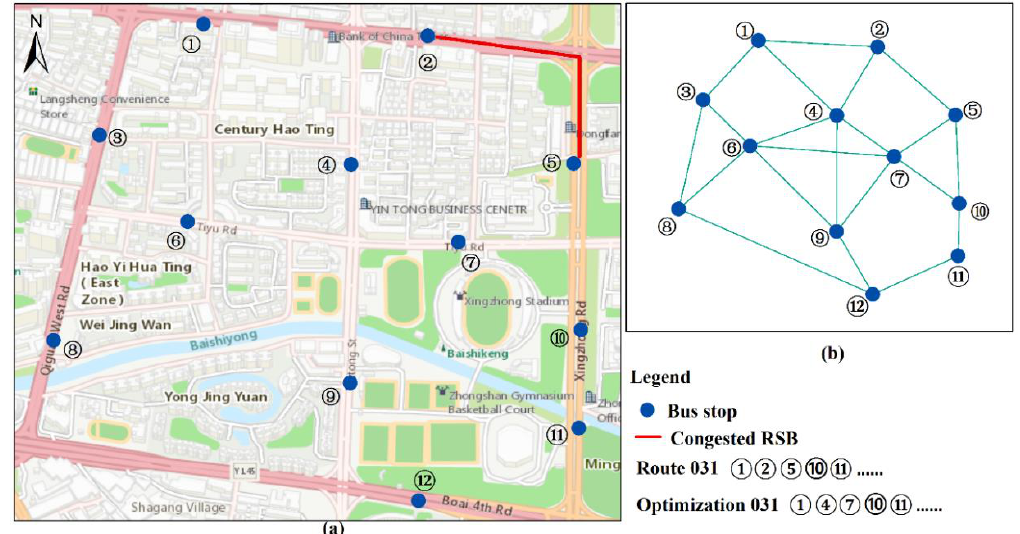
Figure 11. An example of the public transport network. ( a ) Spatial distribution of the congested RSB. ( b ) Modified transport network.